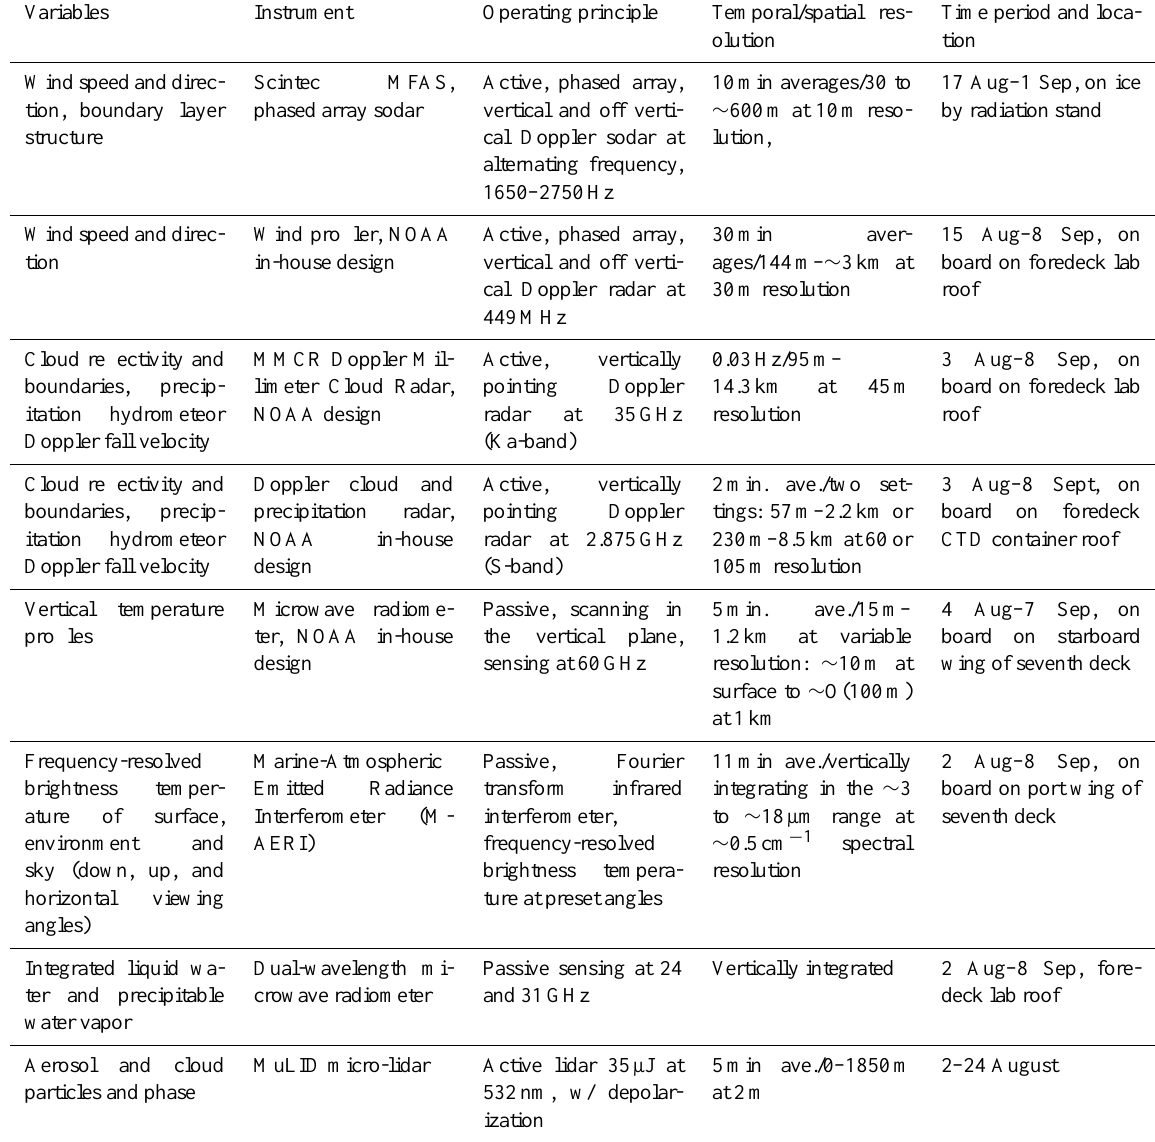
Table A5. Summary of the meteorological surface-based remote-sensing